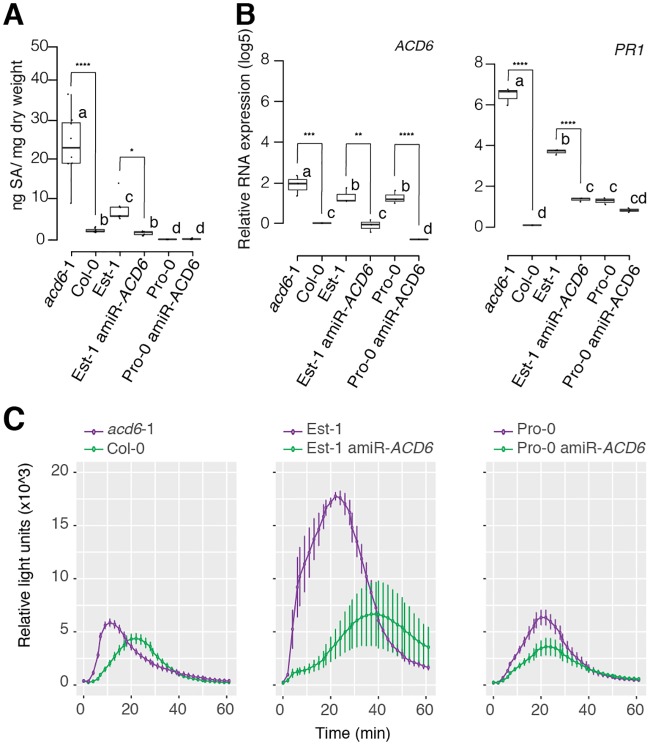
ACD6-dependent suppression of salicylic acid accumulation and flg22 responses in Pro-0.(A) SA levels in lines with different ACD6 alleles, n = 10 per line. Asterisks indicate pairwise Student’s t-test results (p<0.0001; Holm adjusted). Letters indicate significantly different groups (p<0.0001; post hoc Tukey’s HSD). (B) ACD6 and PR1 expression in different T1 individuals (n = 4), normalized to Col-0. Asterisks indicate significance in pairwise Student’s t-tests (*p<0.05, **p<0.01, ***p<0.001, ****p<0.0001; Holm adjusted). Letters indicate significantly different groups (p<0.0001; post hoc Tukey’s HSD). (C) H2O2 production in response to flg22 (n = 4). Error bars represent standard errors. This experiment was repeated four times with similar results.